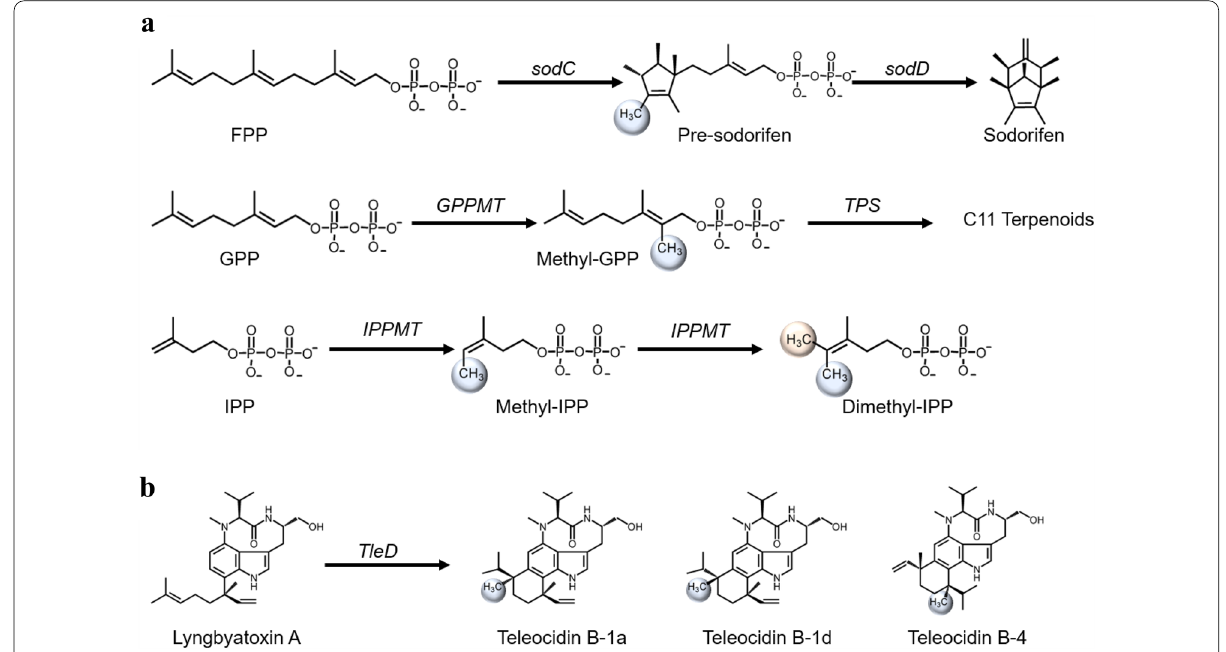
Fig. 3 Reactions of recently discovered novel methyltransferases. In silico tools have been used to discover these enzymes (Table 1). a Methyltransferase reactions that modify terpenoid precursors. IPP, isopentenyl pyrophosphate; GPP, geranyl pyrophosphate; FPP, farnesyl pyrophosphate. b Bifunctional methyltransferase and cyclase involved in teleocidin